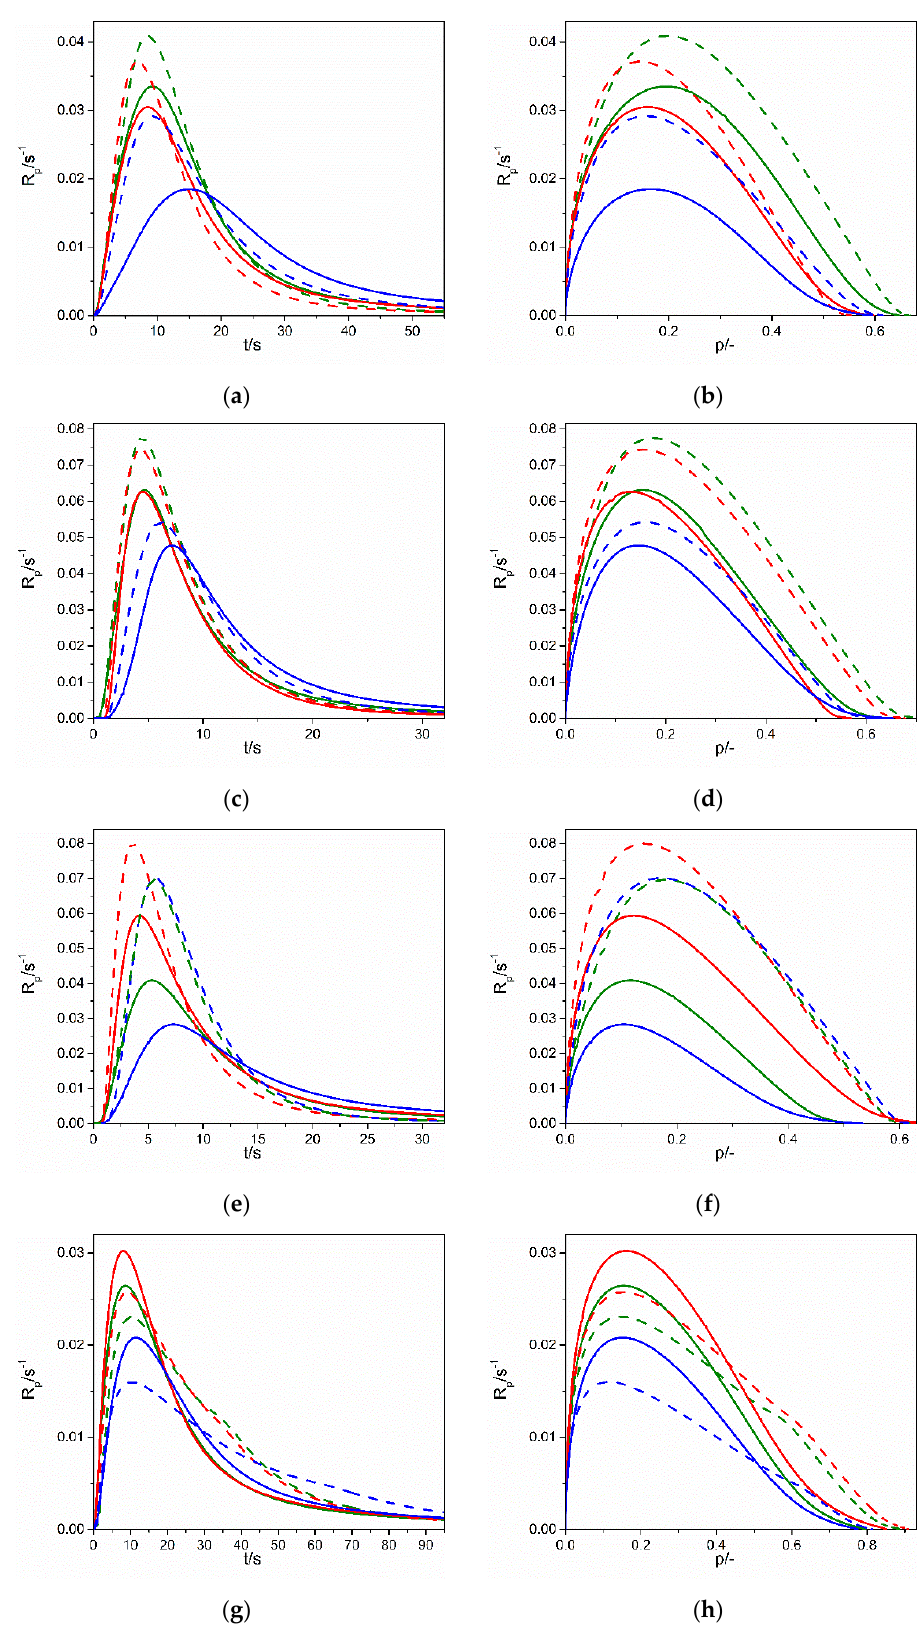
Figure 4. Dependence of polymerization rate (R p ) on ( a , c , e , g ) polymerization time (t) and ( b , d , f , h ) conversion ( p ) for thiol–GBDA systems ( a , b ), thiol–TAT systems ( c , d ), thiol–TATT systems ( e , f ) and thiol–DAP systems ( g , h ) in bulk (solid lines) and in 70 wt.% of EMImNTf 2 (dashed lines). Used thiols: TMPTP (green line), PETMP (red line), PETMB (blue line). Table 4. Maximum polymerization rate (R p max , s − 1 ) and time for reaching R p max (t max , s). TMPTP